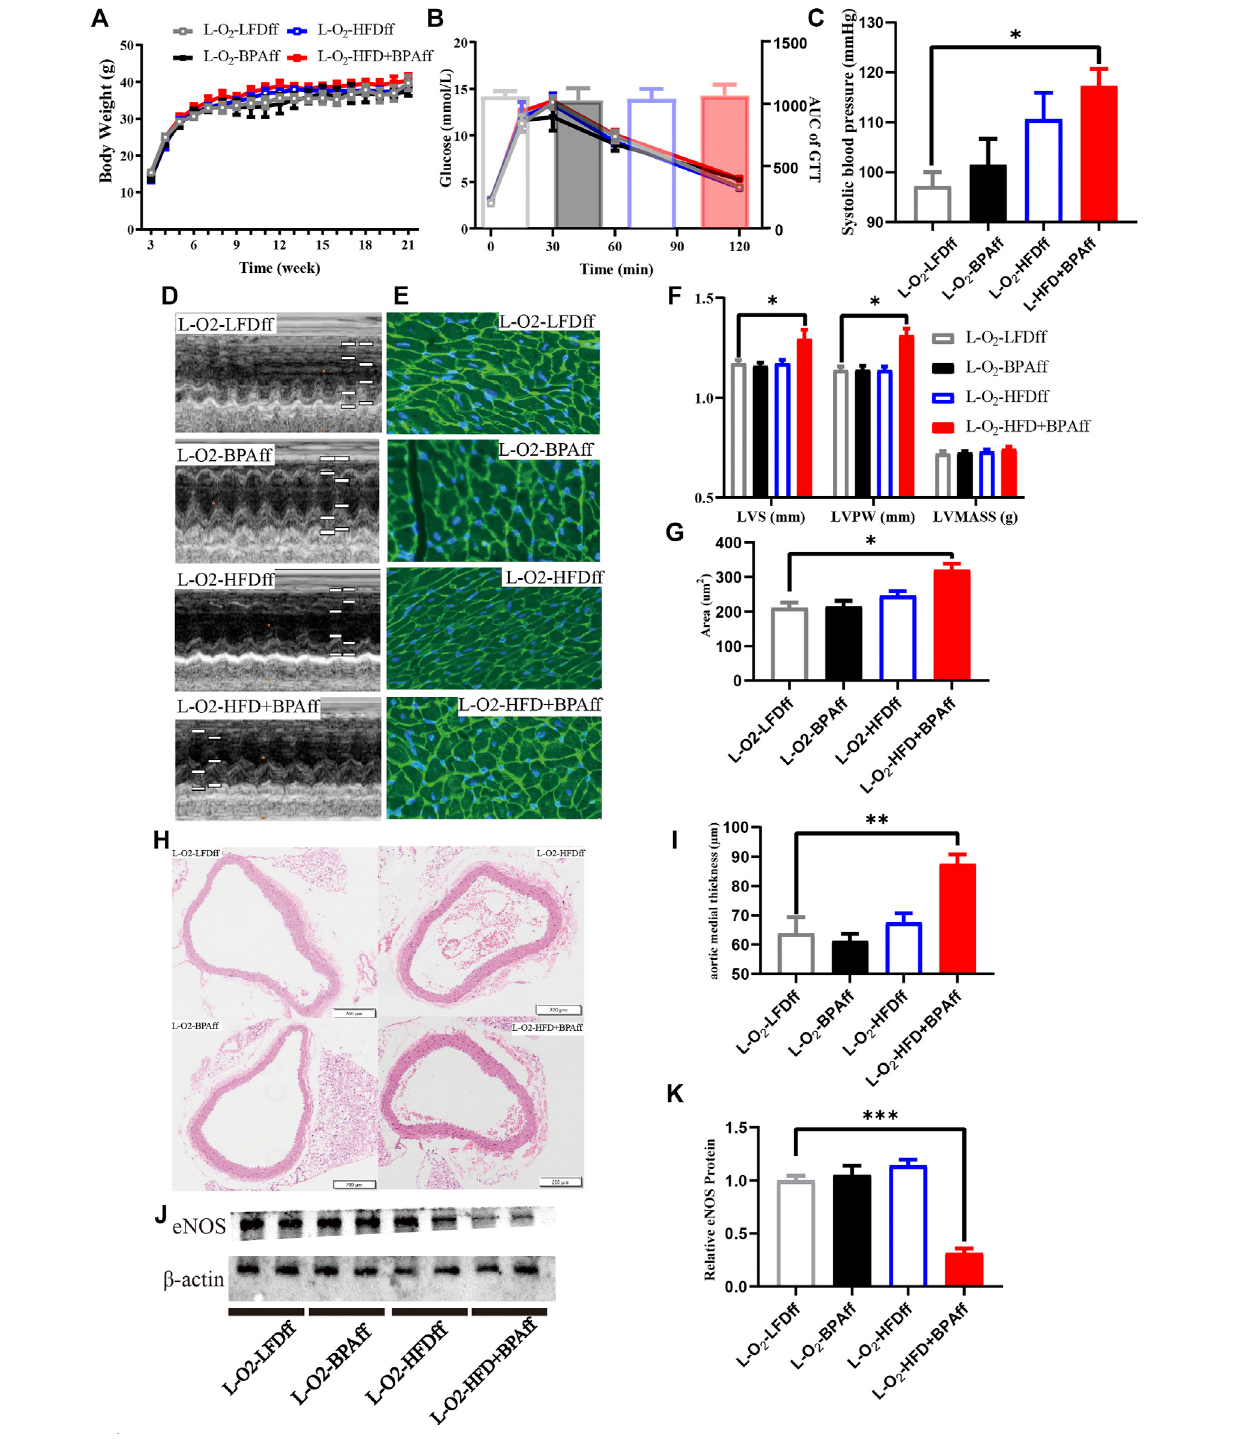
FIGURE3| HFD,BPAand theircombination affect weight gain,metabolic pro fi le ofmaternal female F2. (A,B) Theweight and glucose tolerance difference among the four groups ofmatrilineal female F2 from weaning to21 weeks. (C) The SBPamong the four groups ofmatrilineal female F2. (D,F) Echocardiograms among thefour groups of matrilineal female F2. (E,G) Representative photomicrographs depicting WGA staining of cardiomyocytes and Average cardiomyocyte area of matrilineal female F2. (H,I) Representative photomicrographs depicting hematoxylin eosin staining of aorta and arterial media thickness. (J,K) Western blotting results and quantitative analysis for aorta of matrilineal female F2. Data are mean ± SEM and were analyzed by two-way ANOVA with a posthoc test. * p < 0.05. ** p < 0.01. *** p < 0.001, BPA, HFD, BPA + HFD vs LFD.